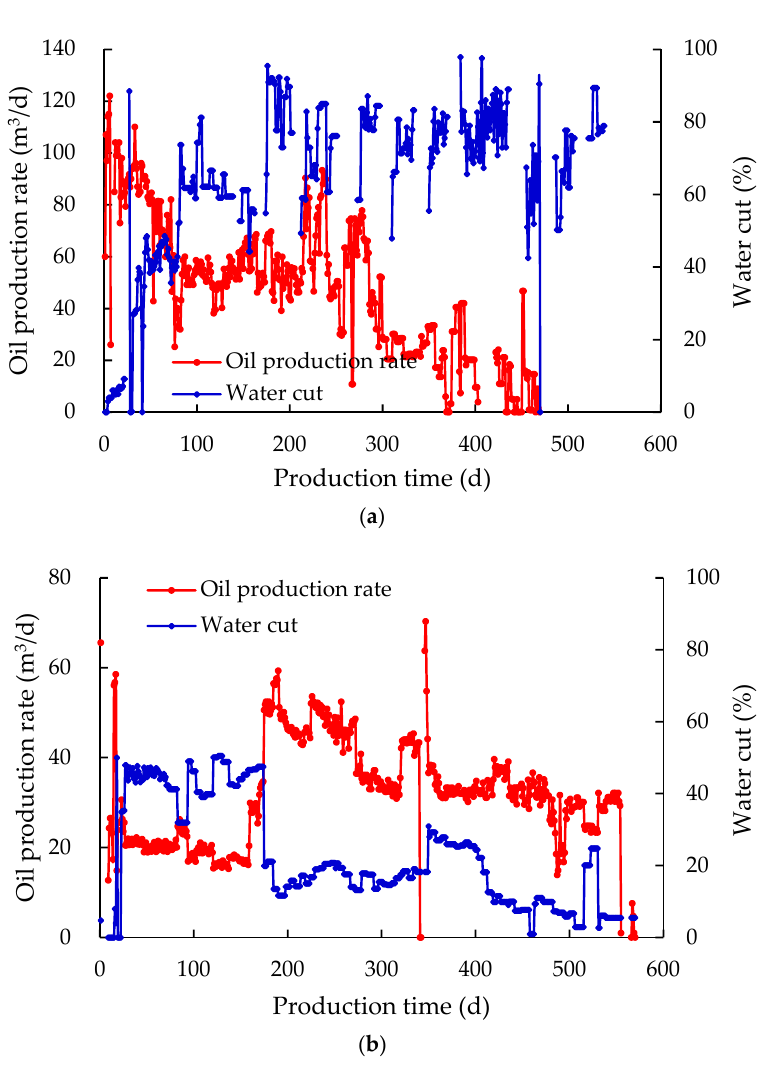
Figure 4. Schematic diagram of typical water influx behavior patterns: ( a ) abrupt watered-out; ( b ) fluctuation or staircase rise in water cut.